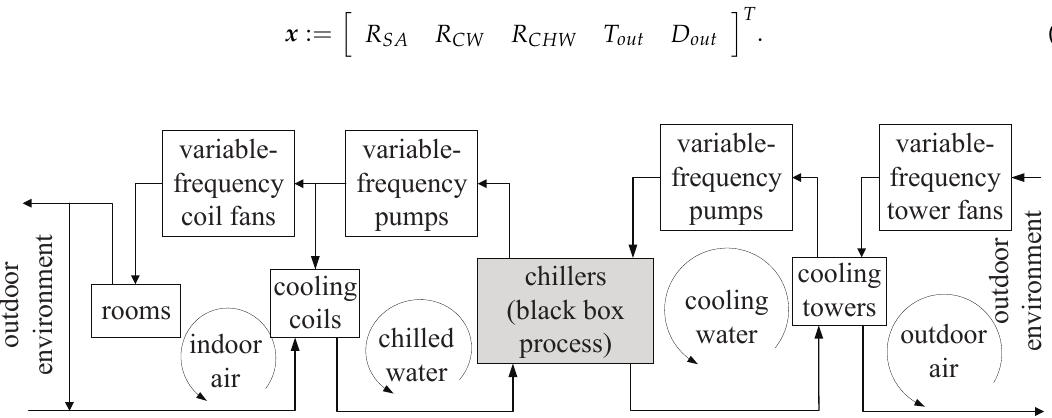
Figure 1. The schematic diagram of an experimental HVAC